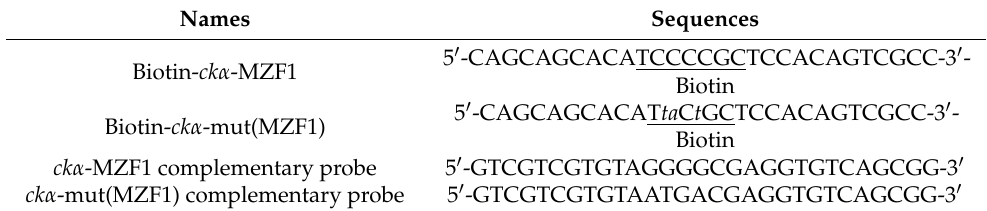
Table 2. List of DNA probes used in EMSA. The MZF1 core sequence is underlined. Names